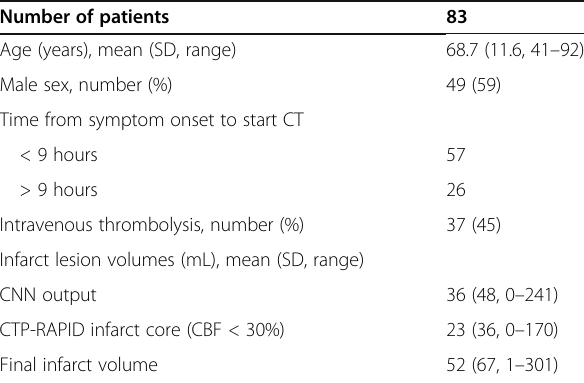
Table 1 Patient characteristics Number of